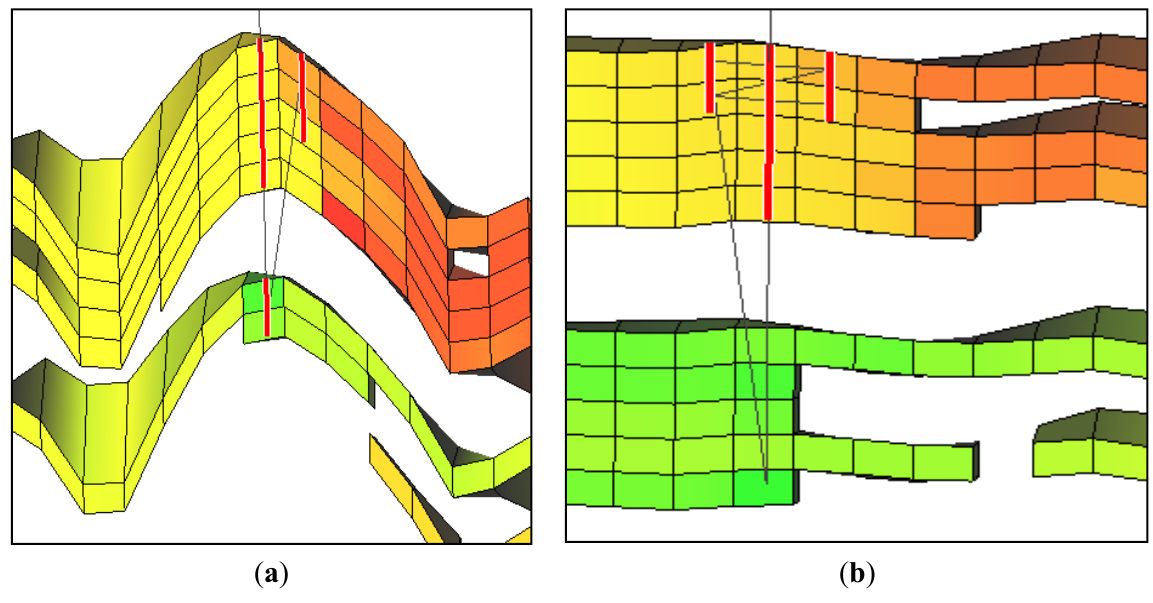
Figure 4. Cross section along the borehole (an example of current oil saturation cube). ( a ) Radial drilling; ( b ) Acid